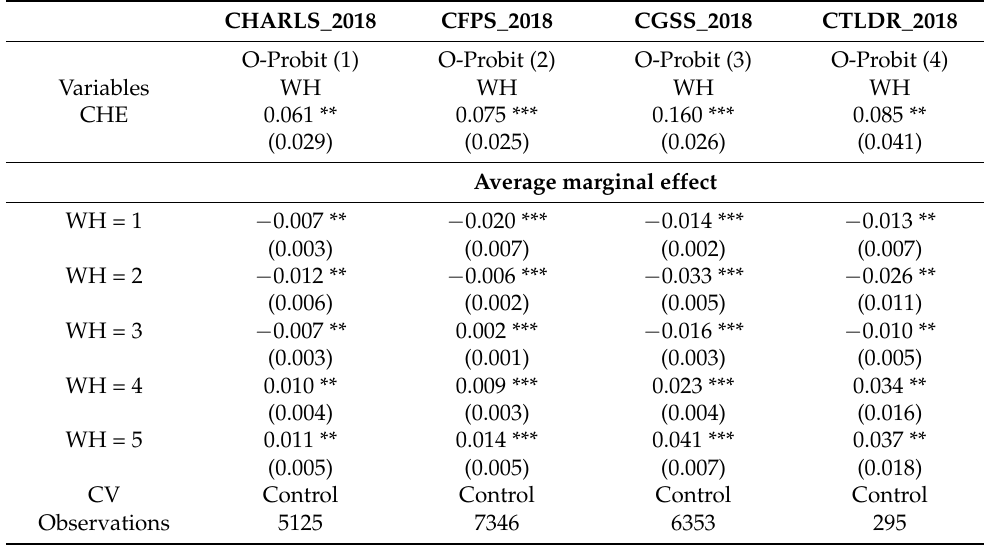
Table 4. Robustness test results for replacement sample